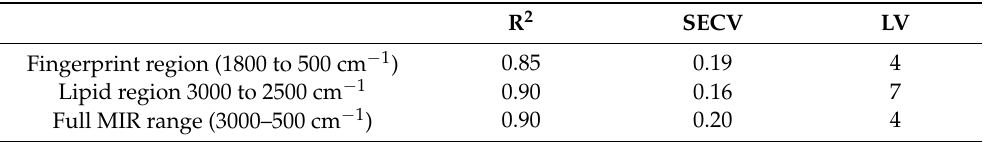
Figure 4. Principal component score plot ( A ) and loadings ( B ) of the 6th instar samples sourced from the two waste streams (bread and vegetables; soy) analyzed using attenuated total reflectance mid-infrared spectroscopy. Table 1. Statistics for the cross-validation prediction of the waste stream diets in the combined set of 5th and 6th instar samples analyzed using attenuated total reflectance mid-infrared